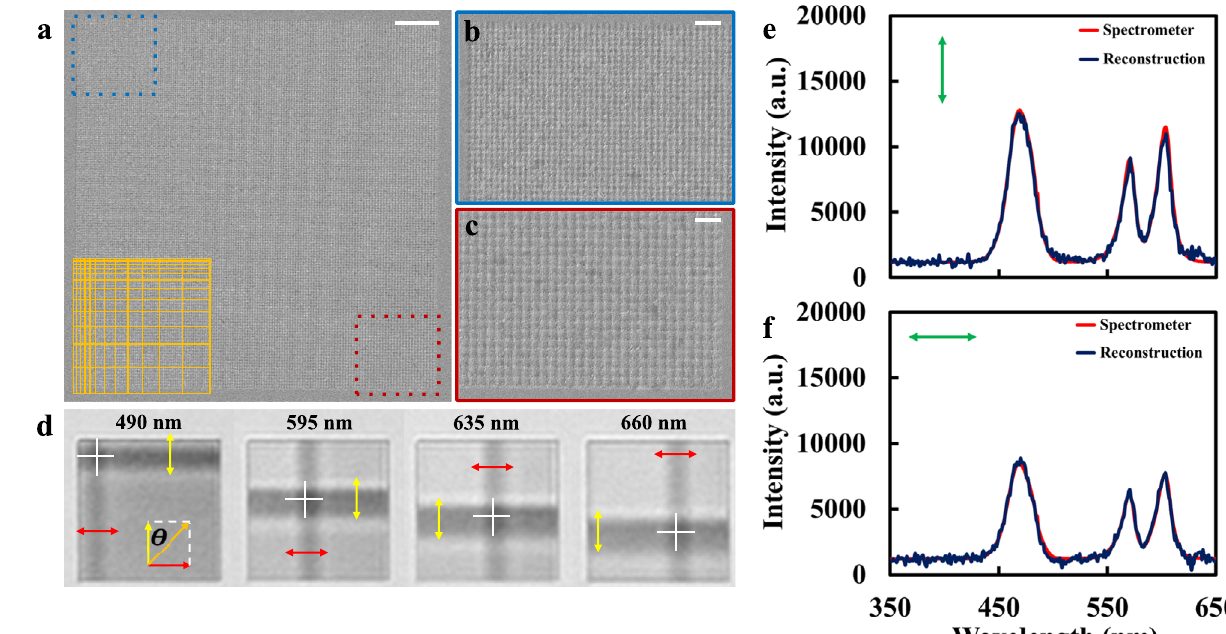
Fig. 4 | 2D chirped grating for polarimetric spectroscopy. a SEM image of a preliminary sample with the period varying from 439 to 739nm along two direc- tions.Scalebaris10 µ m. b,c Zoom-inimagesattwocornersofthechirpedgrating. Zoom-in regions correspond to squared off areas of matching color in ( a ). Scale barsare2 µ m. d Re fl ectionimagesofthegratingundertheilluminationof490,595,